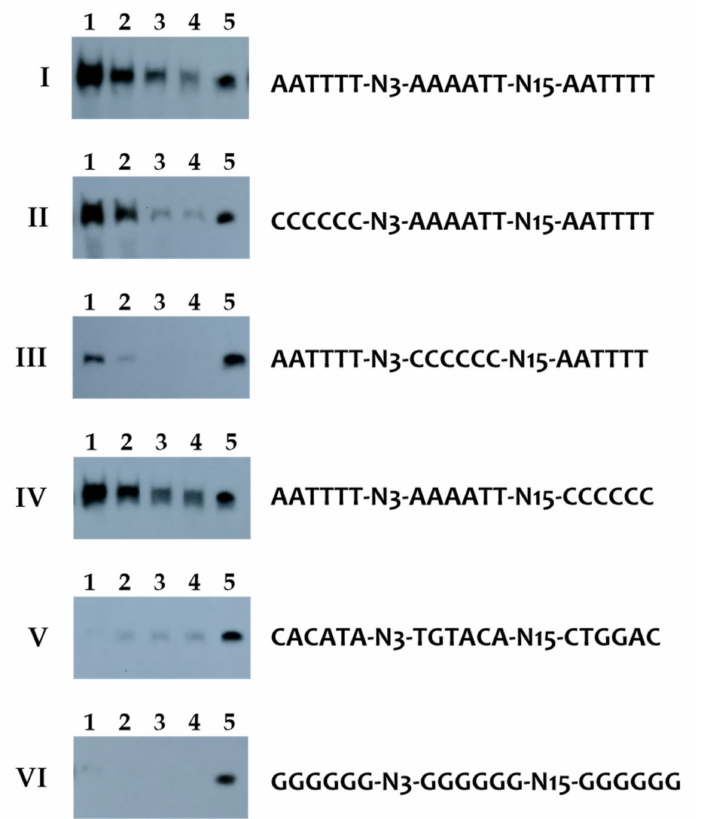
Figure 4. DAPA experiments showing the binding specificity of the CodY-like protein of C. evryensis DSM19522. Lanes 1 to 4, 2.5 µ M, 0.5 µ M, 0.1 µ M, and 0.02 µ M of the purified His-CodY DSM were used in the binding reactions, respectively. Lane 5, 1.25% of the probe used in the reaction is